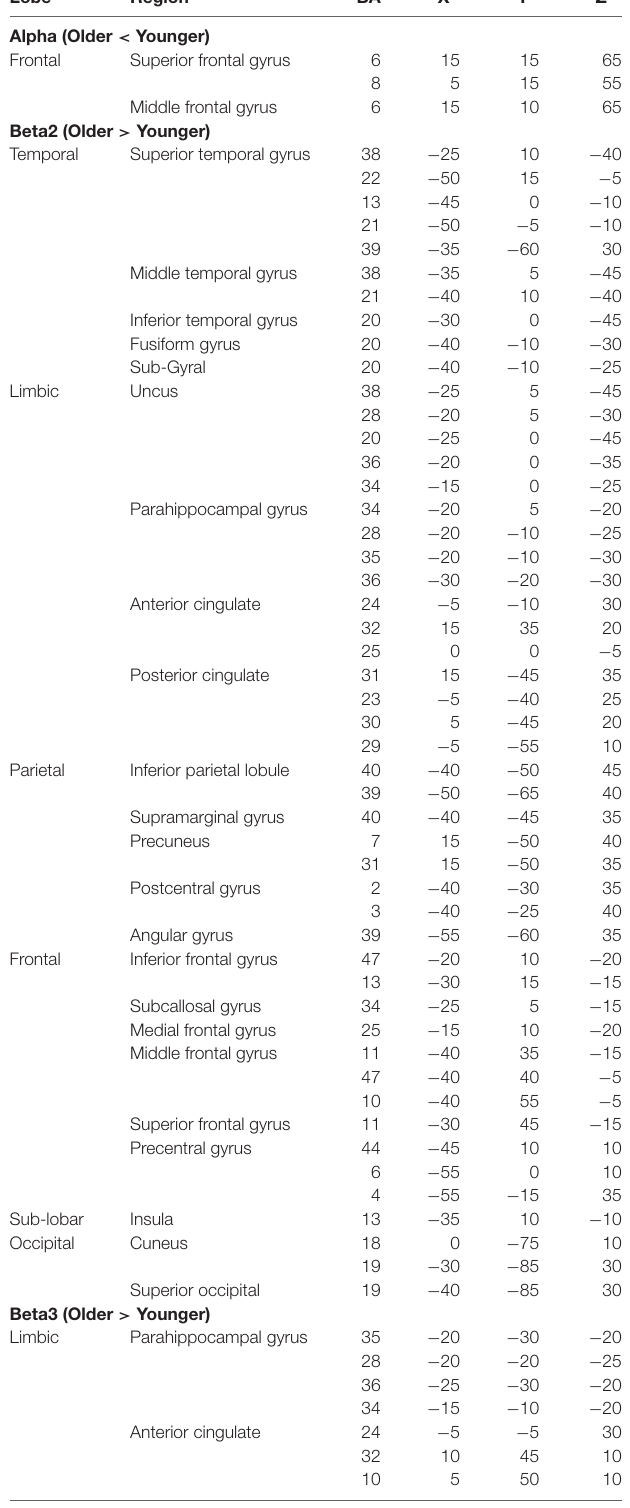
TABLE 1 | Summary of significant results from whole-brain eLORETA comparisons between older and younger groups for alpha, beta2, and beta3 frequency